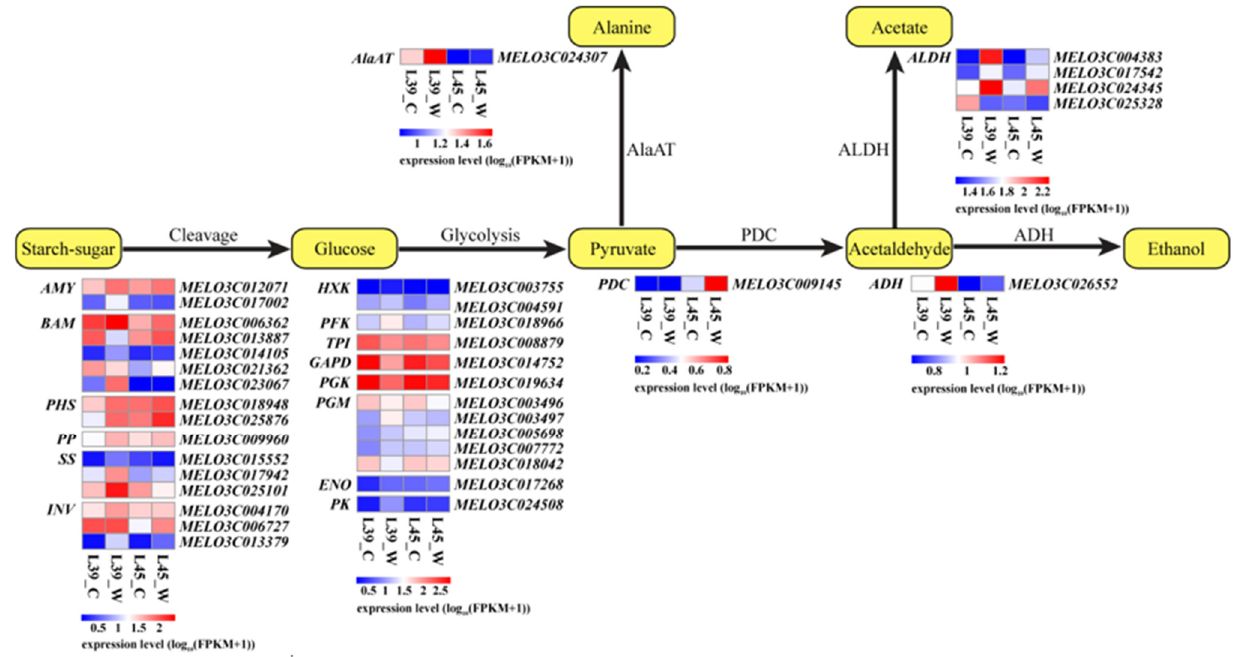
Figure 8. Expression of genes associated with sugar cleavage, glycolysis, and fermentation in ‘L39’ and ‘L45’, under control and waterlogging stress conditions. The levels of gene expression are shown by log 10 (FPKM+1). AMY, α -amylase; BAM, β -amylase; PP, phosphoglucan phosphatase; PHS, α -glucan phosphorylase; SS, sucrose synthase; INV, invertase; HXK, hexokinase; PFK, phosphofructokinase; TPI, triosephosphate isomerase; GAPD, glyceraldehyde-3-phosphate dehydrogenase; PGK, phosphoglycerate kinase; PGM, phosphoglycerate mutase; ENO, enolase; PK, pyruvate kinase; PDC, pyruvate decarboxylase; AlaAT, alanine aminotransferase; ALDH, aldehyde dehydrogenase; ADH, alcohol dehydrogenase.